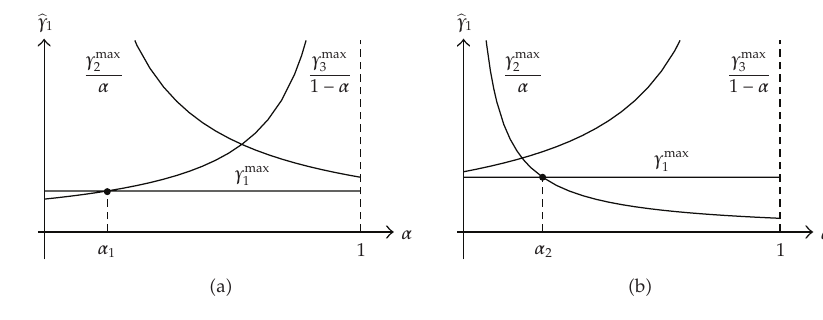
Figure 12: (cid:4) a (cid:7) case γ max